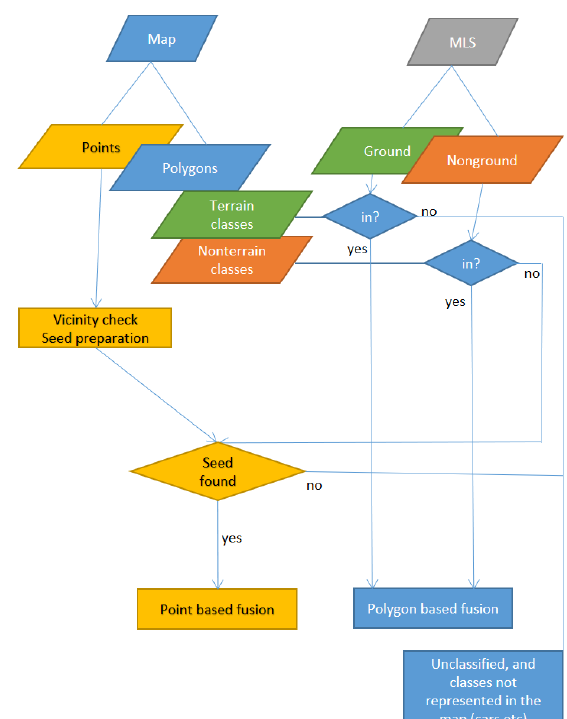
Figure 2. Workflow to combine map polygons and points with ground and non-ground MLS